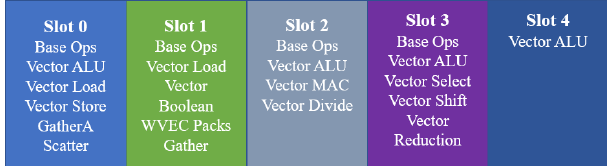
Figure 4. Five instruction issue slots and operations of vision DSP (the illustration is from the Cadence Company technical material).